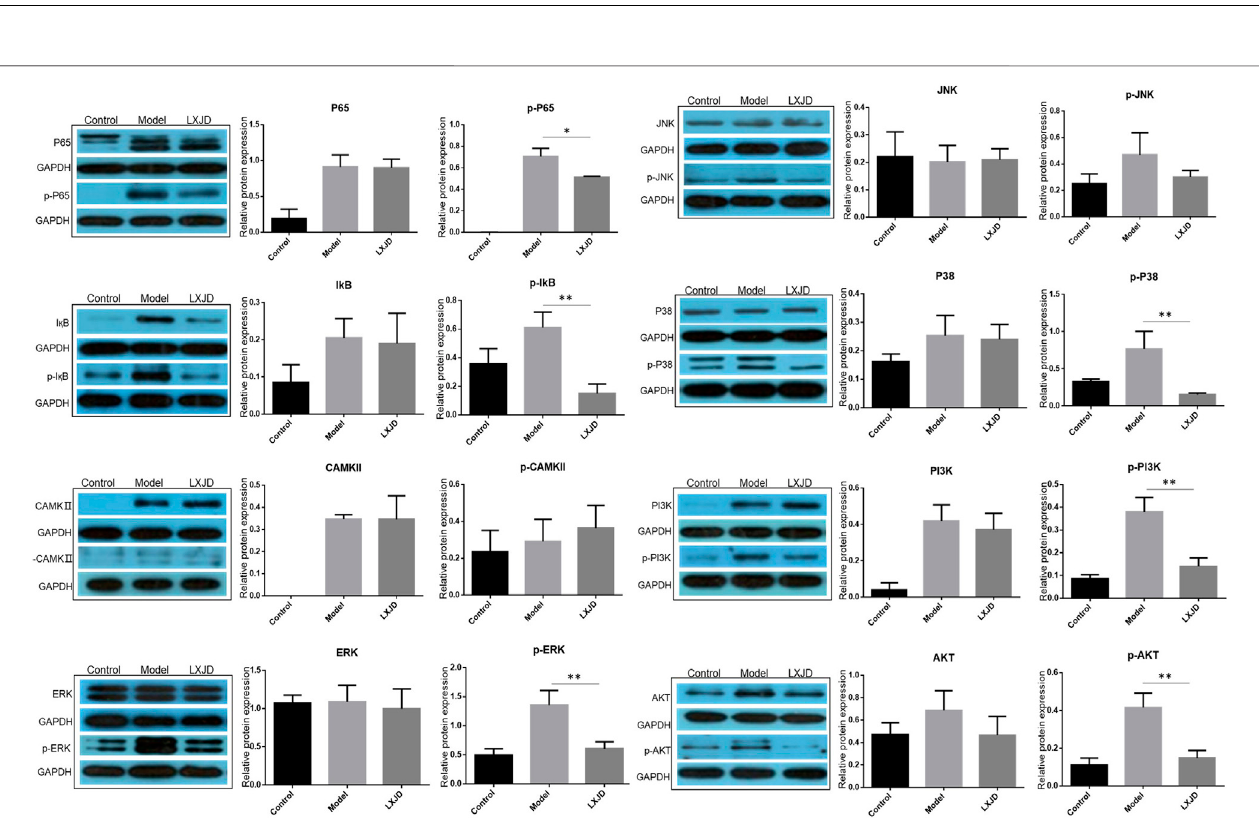
FIGURE 7 | Effects of LXJD formula on IMQ-induced psoriasis-like dysfunction pathway. Levels of P65, p-P65, I қ B, p-I қ B, CAMK Ⅱ , p-CAMK Ⅱ , ERK, p-ERK, P38, p-P38,JNK,p-JNK,PI3K,p-PI3K,AKT,andp-AKTproteinsinskinlesionsaredetectedbyWesternblot.Semiquantitativeanalysiswasperformed.* p < 0.05,** p < 0.01 indicating signi fi cant inhibition of LXJD as compared to model group. Data are shown as mean ± SD. n (cid:2) 3 mice.